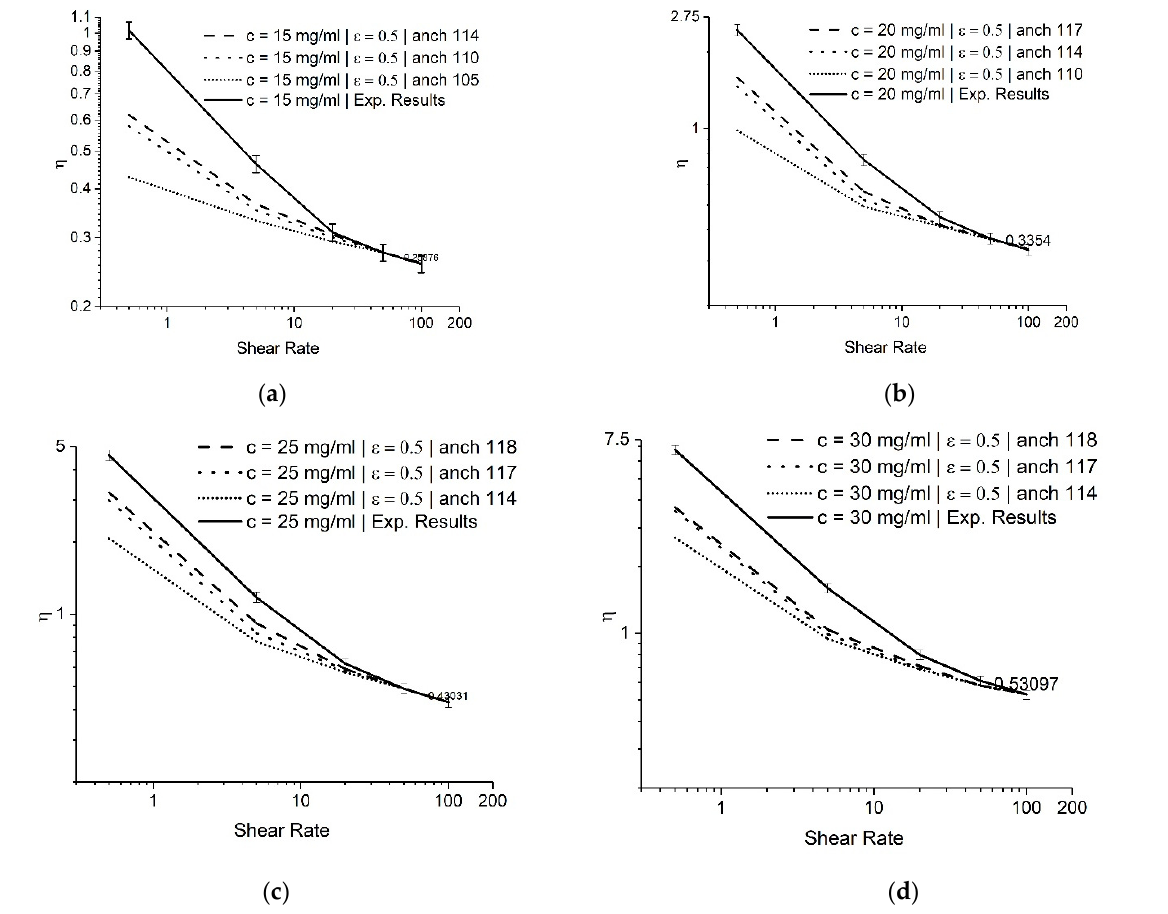
Figure 9. Dimensionless viscosity vs. shear rate at different anchoring angles for ϵ = 0.5 at ( a )15, ( b )20, ( c )25, and ( d )30 mg/mL concentrations using the EL theory.